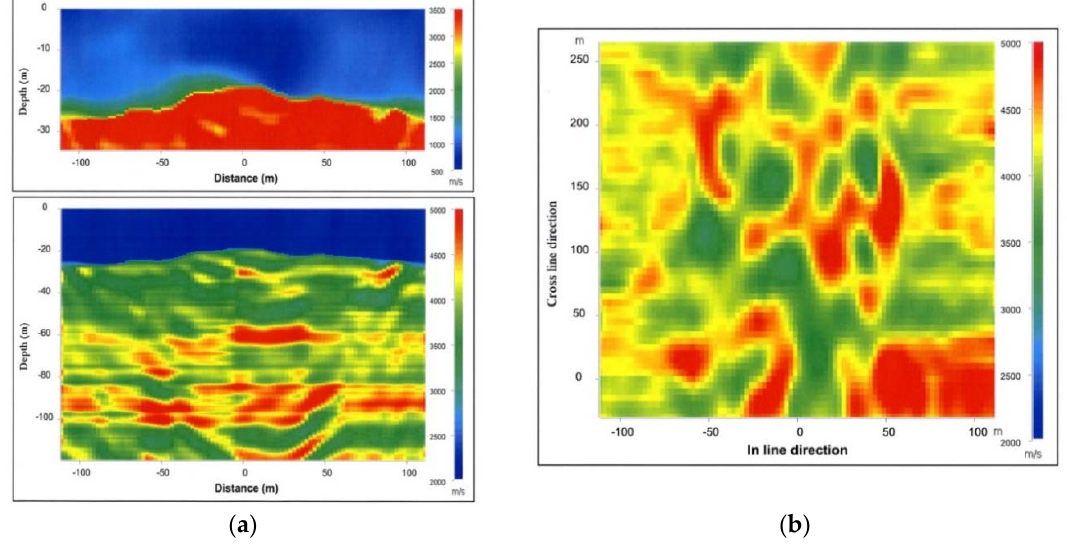
Figure 3. Seismic processing, ( a ) inline #31 pseudo-velocity section ( upper part : zoom in the 0–35 m depth interval) ( b ) pseudo velocity map at 87 m in depth.